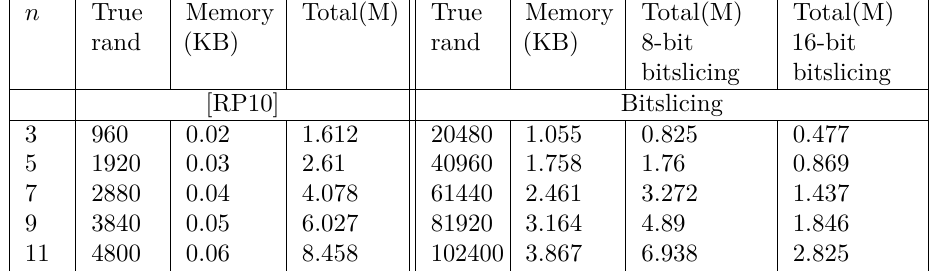
Table 7: Higher-order masked S-box computation using [RP10] with FullRefresh and 8-bit bitslicing. Also, 16-bit bitslicing using 32-bit ISW-AND [GR17]. The true randoms and the total memory required for AES-128 are given in bytes and KB, respectively. The total execution is represented in millions of clock